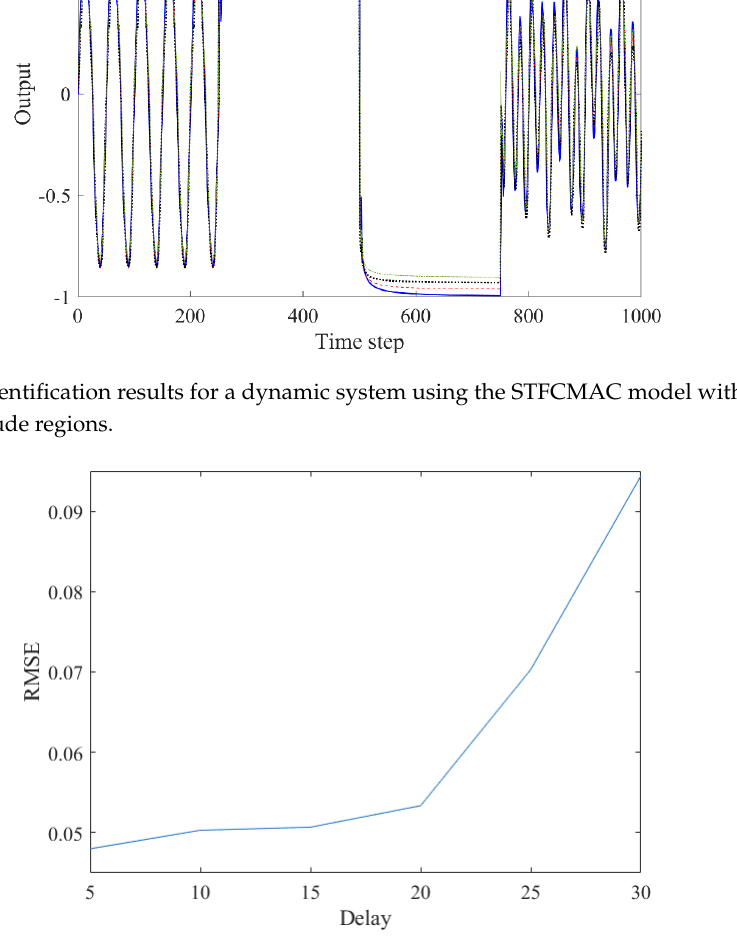
Table 2. A comparison of different identifiers in terms of the dynamic system identification of longer input delays. Models